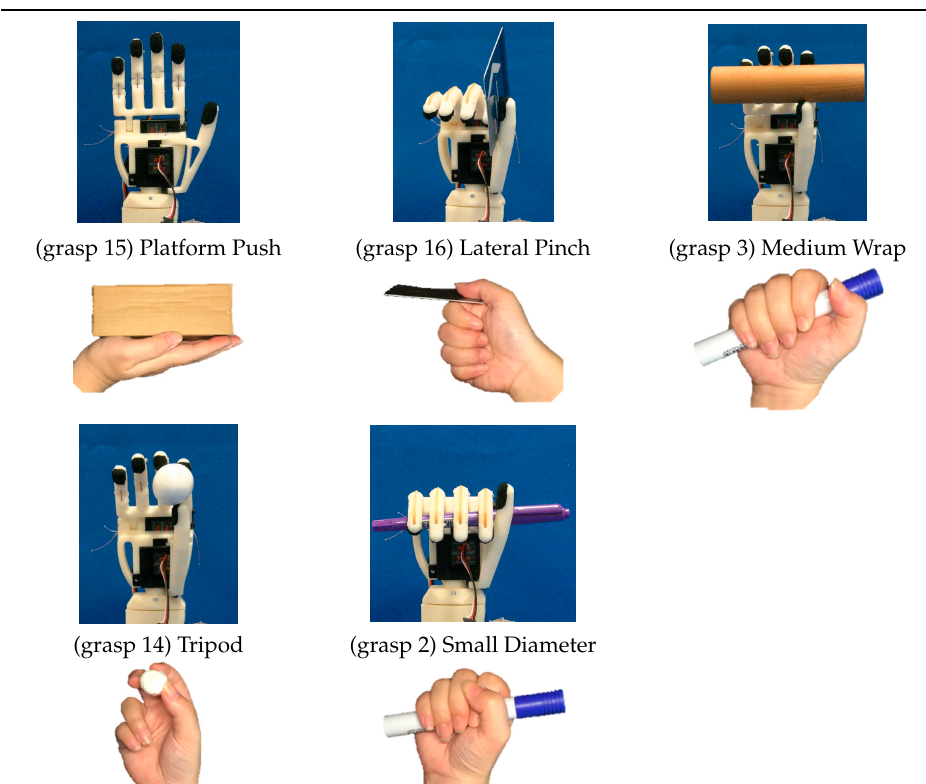
Table 6. Achievable motion types (stable linkage type).